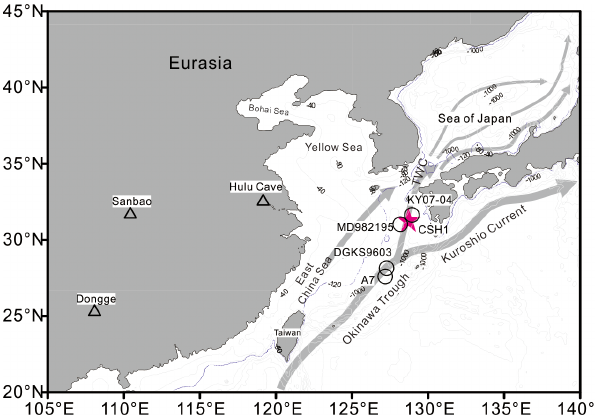
Figure 1. The pink star indicates core CSH1. The open circles means other cores mentioned in this study and the triangles denote the stalagmite caves in East China. Arrows denote simplified sur- face currents in the study region. The blue dashed curve stands for the − 120m